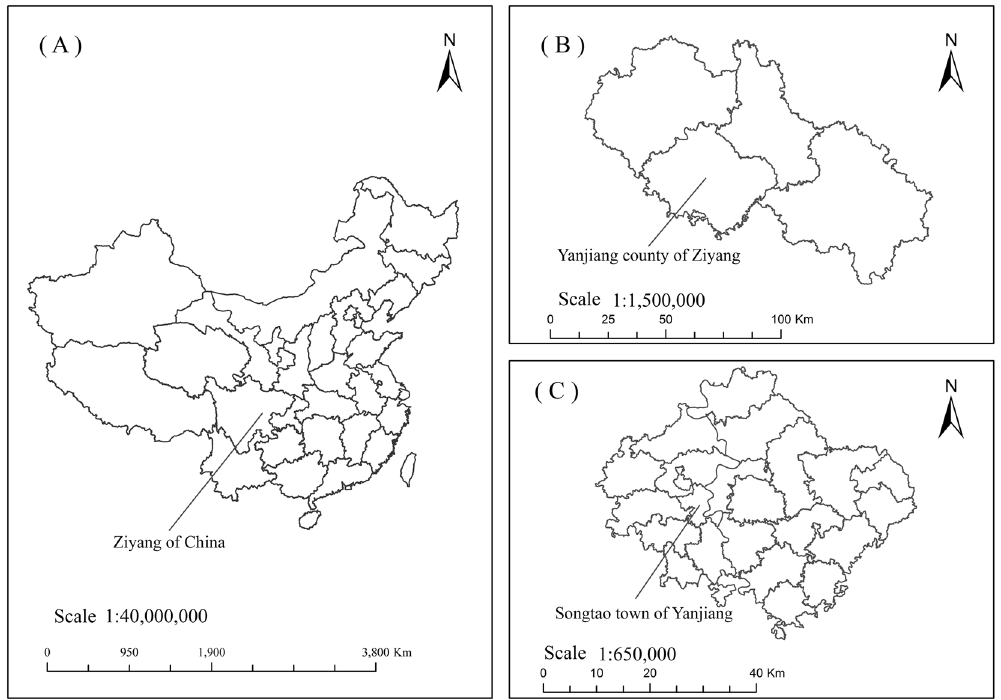
Figure 6. Location of the study area. Note: This map was made by ArcGIS 10.0 (http://www.esri.com/arcgis/ about-arcgis).